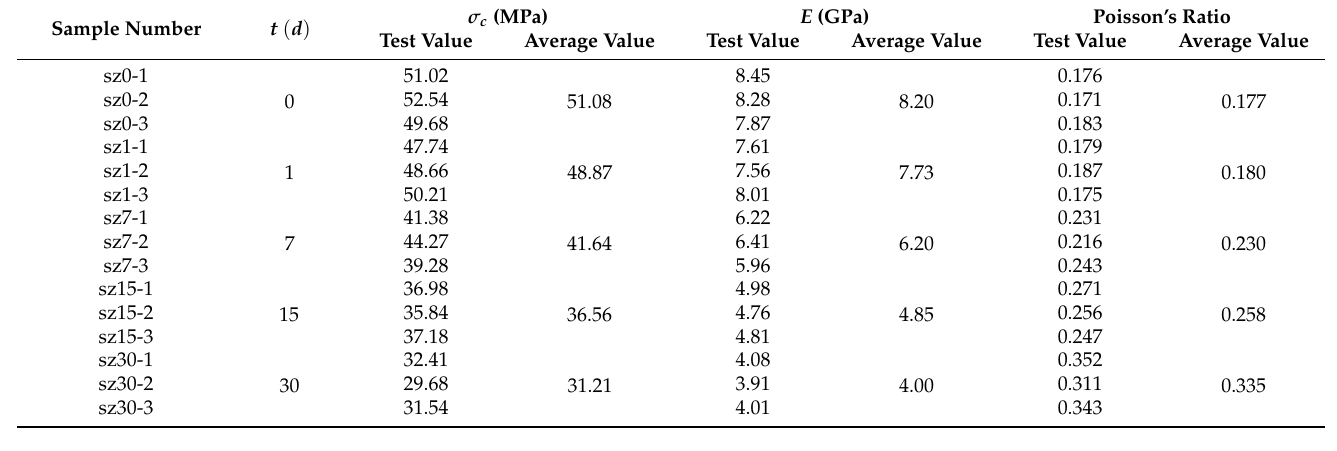
Table 3. The mechanical parameters of the gypsum rock obtained from the triaxial compression tests.